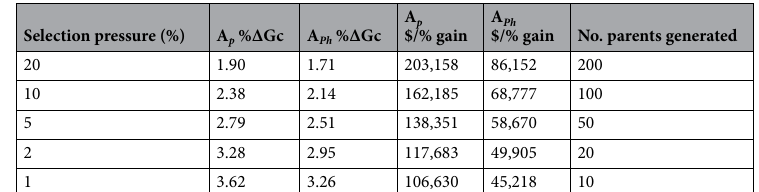
Selection pressure